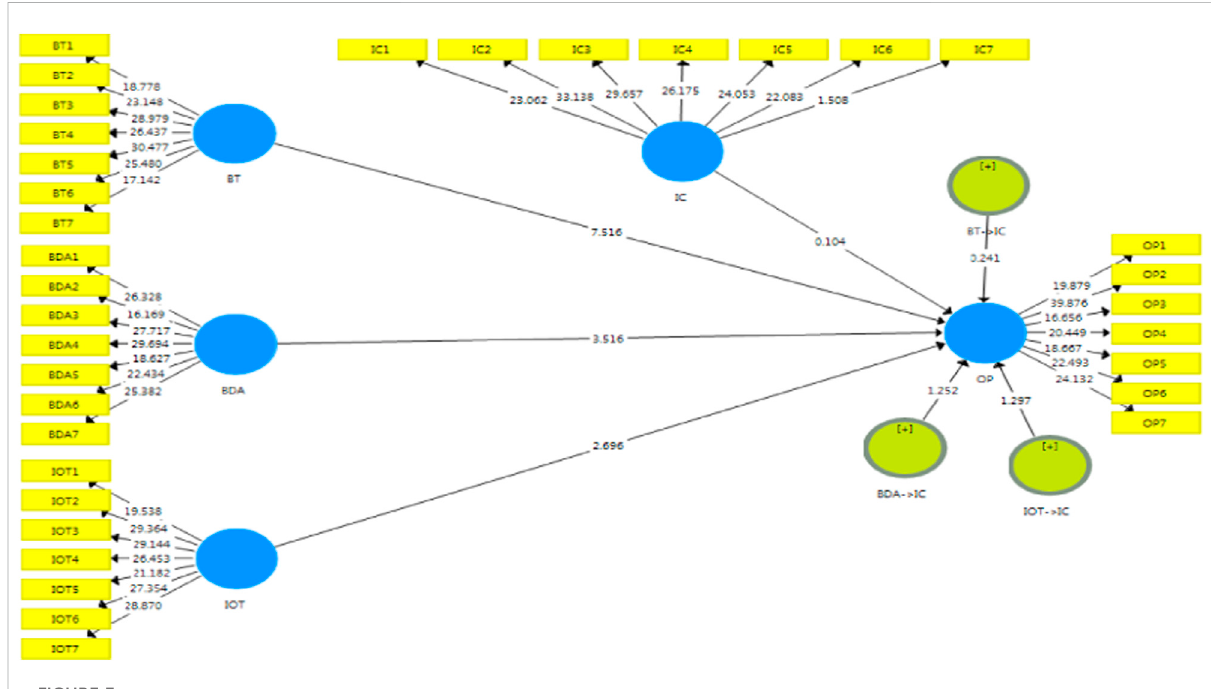
FIGURE 3 PLS algorithm with the interaction of innovation